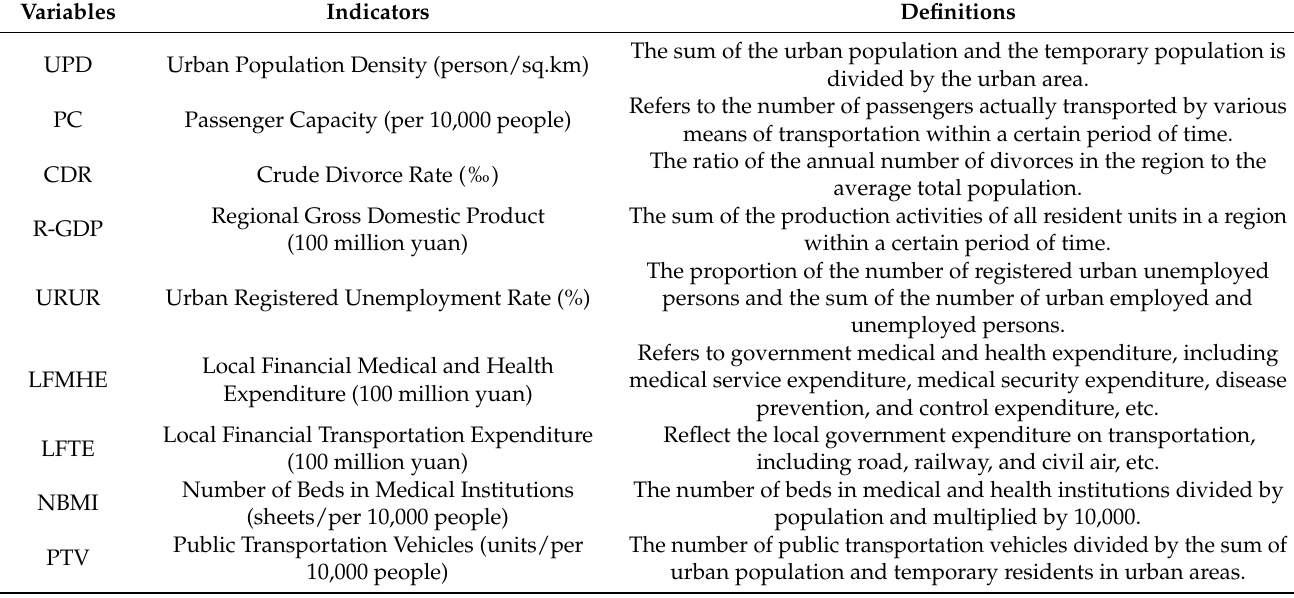
Table 1. Definitions of social economy and the population indicators,